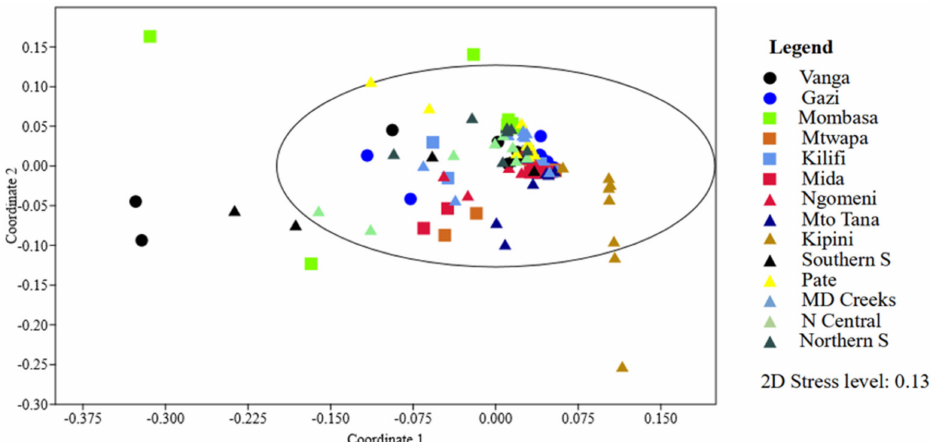
Figure 3. Non-metric multidimensional scaling (nMDS) of sites in two dimensions (2D) based on species abundance. The ellipse shows the 95% confidence interval. The stress level is 0.1304. Southern S is Southern Swamps, MD Creeks is Mongoni-Dodori Creeks, N Central is Northern Central Swamps and Northern S is Northern